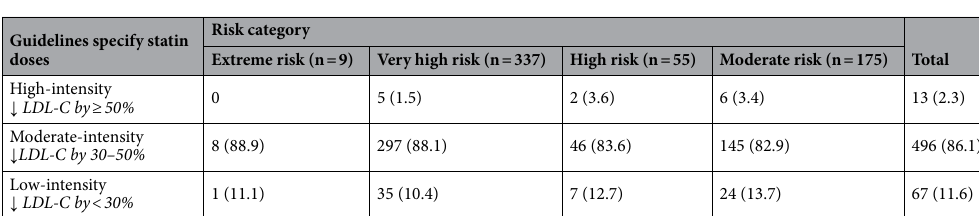
Risk category Guidelines specify statin doses TotalExtreme risk (n = 9) Very high risk (n = 337) High risk (n = 55) Moderate risk (n = 175) High-intensity ↓ LDL-C by ≥ 50%